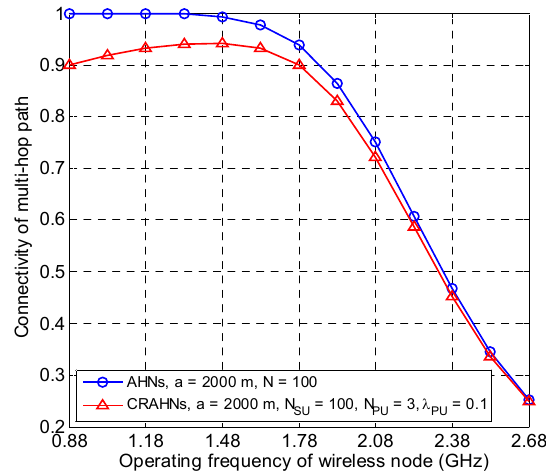
Figure 7 . The connectivity of multi-hop path in CRAHNs and conventional AHNs with different operating frequencies; network size a = 2000 m; number of SUs = 100, number of PUs = 3, average = 0.1. active rate of PU l PU